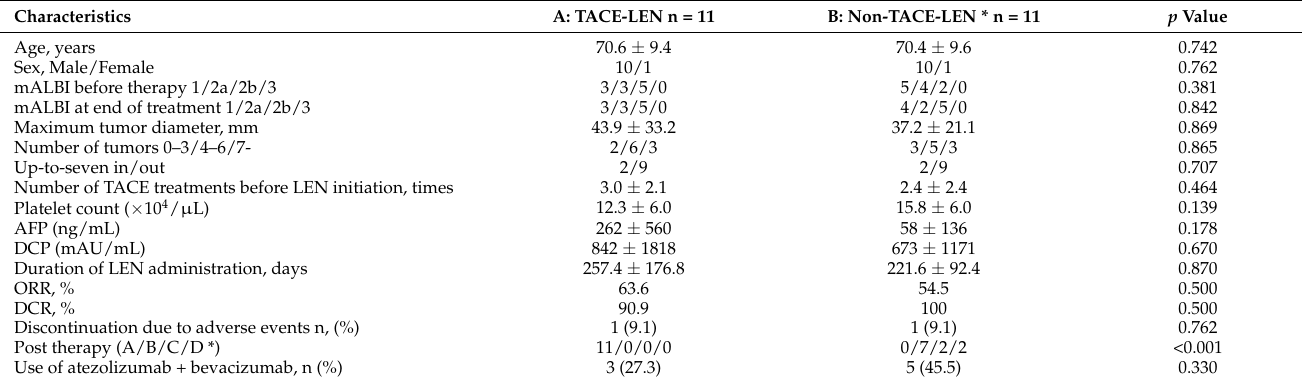
Table 5. Characteristics after propensity score matching.